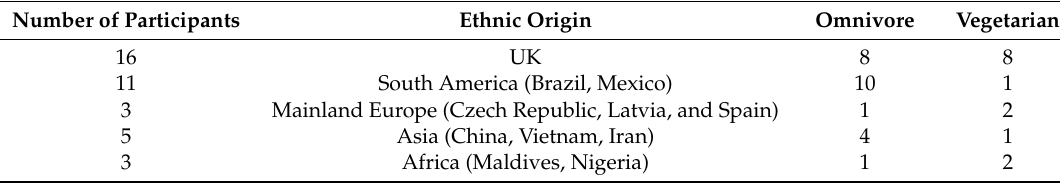
Table 7. A breakdown of the participants by country of origin and omnivore/vegetarian